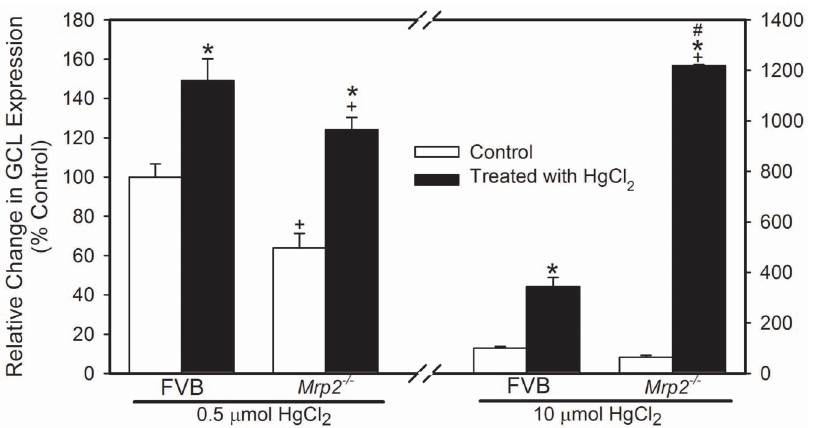
Figure 8. RT-PCR Analysis of Glutamate Cysteine Ligase (GCL) Expression in Mrp2 2 / 2 and FVB Mice. Real-time PCR analyses were carried out on 3-mm slices of kidneys from Mrp2 2 / 2 and FVB mice treated with saline, 0.5 m mol ? kg 2 1 ? 8 mL 2 1 , or 10 m mol kg 2 1 8 mL 2 1 HgCl 2 . Samples were normalized with glyceraldehyde-3-phosphate dehydrogenase (Gapdh). Data represent mean 6 SE of nine samples from three different animals. *, significantly different from mean of corresponding FVB mice (p , 0.05). + , significantly different from the mean of the same strain of mice treated with saline (p , 0.05). # , significantly different from the mean of the corresponding group of mice treated with 0.5 m mol ? kg 2 1 HgCl 2 .